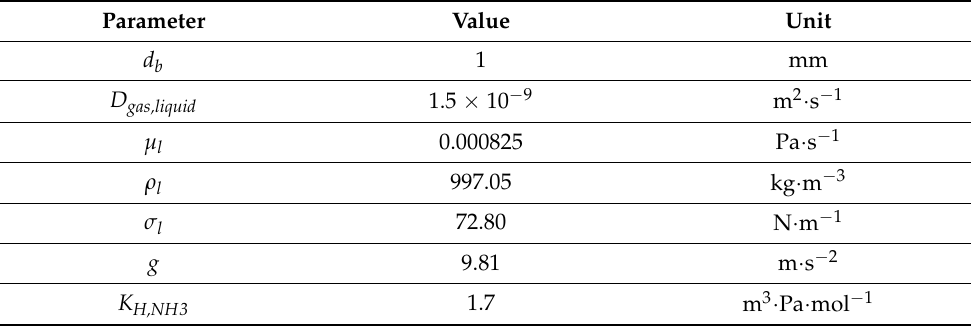
Table 2. Parameters used for the assessment of the volumetric mass transfer coefficient and the nitrogen